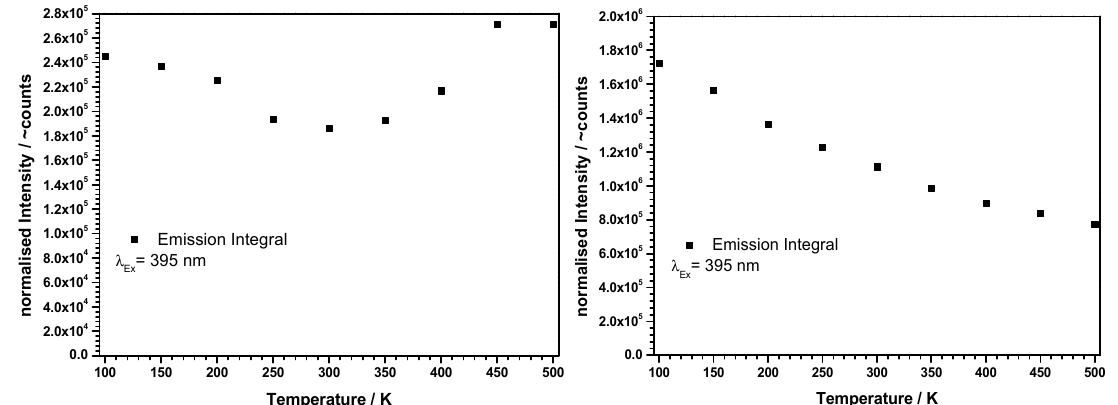
Figure 16. Temperature-dependent emission integrals of NaY[SO 4 ] 2 ∙ H 2 O:Eu 3+ ( left ) and NaY[SO 4 ] 2 :Eu 3+ ( right ) between 100 and 500 K upon 395 nm excitation.